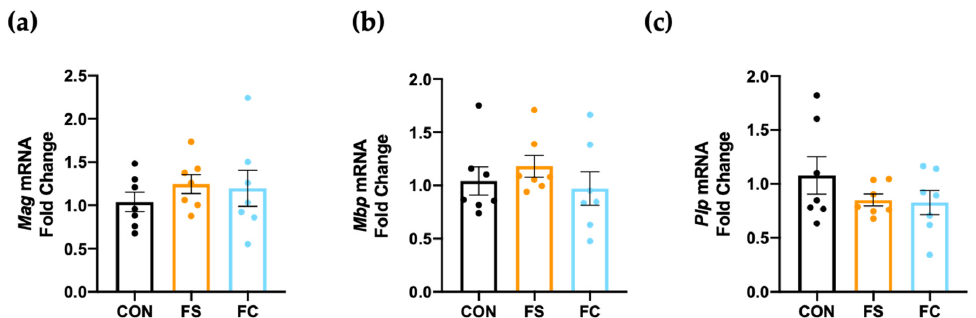
Figure 6. Hippocampal myelination gene expression at PD 15. Expression of major myelin components, ( a ) myelin-asso- ciated glycoprotein ( Mag ), ( b ) myelin basic protein ( Mbp ), and ( c ) myelin proteolipid protein ( Plp ) as assessed in hippo- campal tissue by real-time PCR ( n = 7/group). Values are plotted as fold change relative to CON as the means ± SEM.